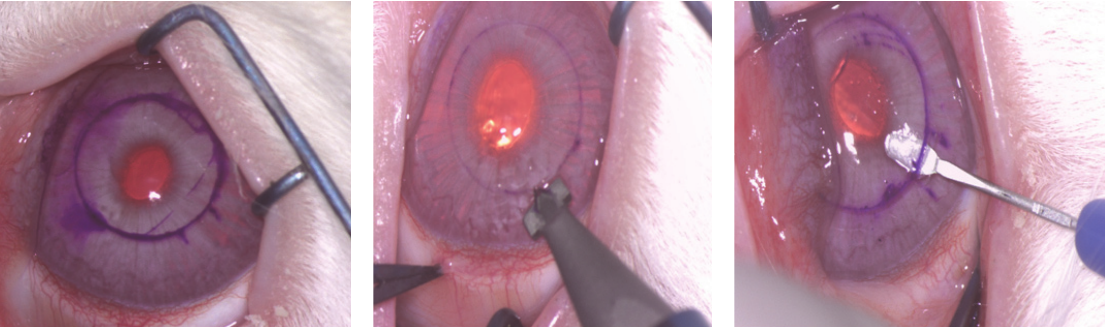
Figure 1: Rabbit eye at the moment of the surgical procedure showing the different steps for the creation of the pocket in the corneal stroma.